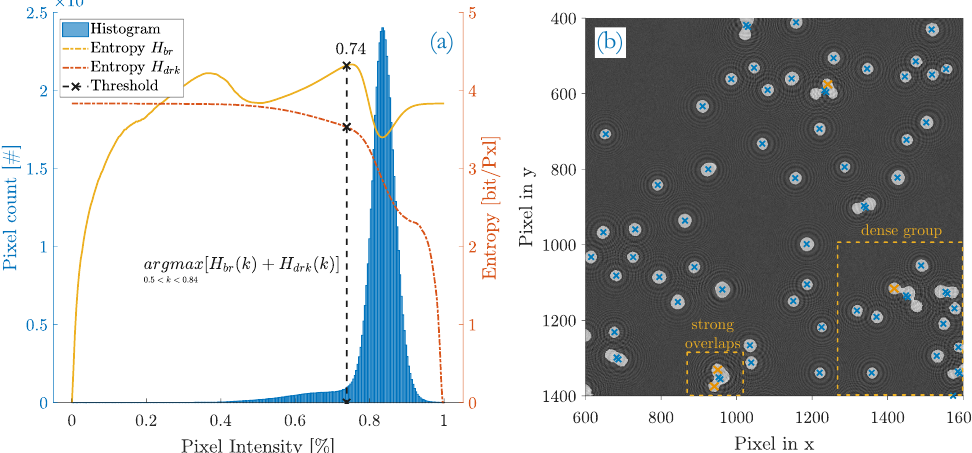
Figure 6. Detection result of blob detection (selected image section). ( a ) histogram and the optimal threshold k opt of the whole image, obtained by maximum entropy thresholding. Equation (8) needs to be confined to a lower threshold limit set to L 1 = 0.5 and an upper limit of L 2 = 0.84 which is the peak of the mainlobe; ( b ) fringe patterns overlaid with the corresponding blobs that result from a threshold at k opt = 0.74. Four hits are missing